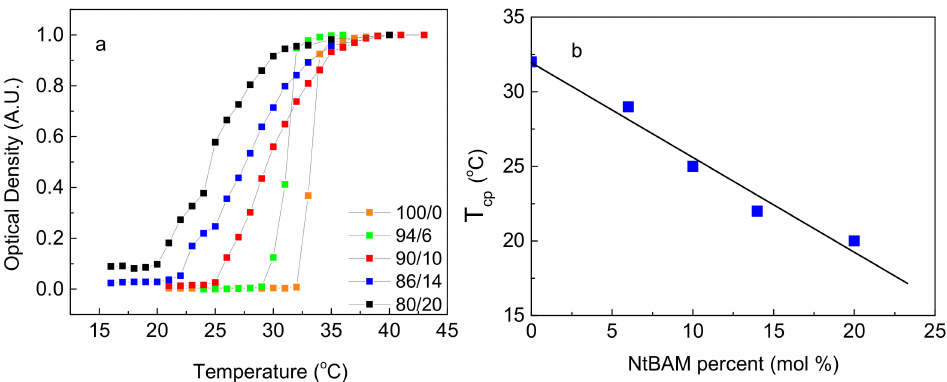
Figure 1. ( a ) Temperature dependence of the normalized optical density at 500 nm of 0.5% w/v aqueous solutions of PNIPAM-NH 2 (orange), P(NIPAM 94 - co -NtBAM 6 )-NH 2 (green), P(NIPAM 90 - co -NtBAM 10 )-NH 2 (red) [22], P(NIPAM 86 -co - NtBAM 14 )-NH 2 (blue), P(NIPAM 80 - co -NtBAM 20 )-NH 2 (black). ( b ) T cp versus NtBAM content (mol %), the line is the linear fitting of the data (R 2 =